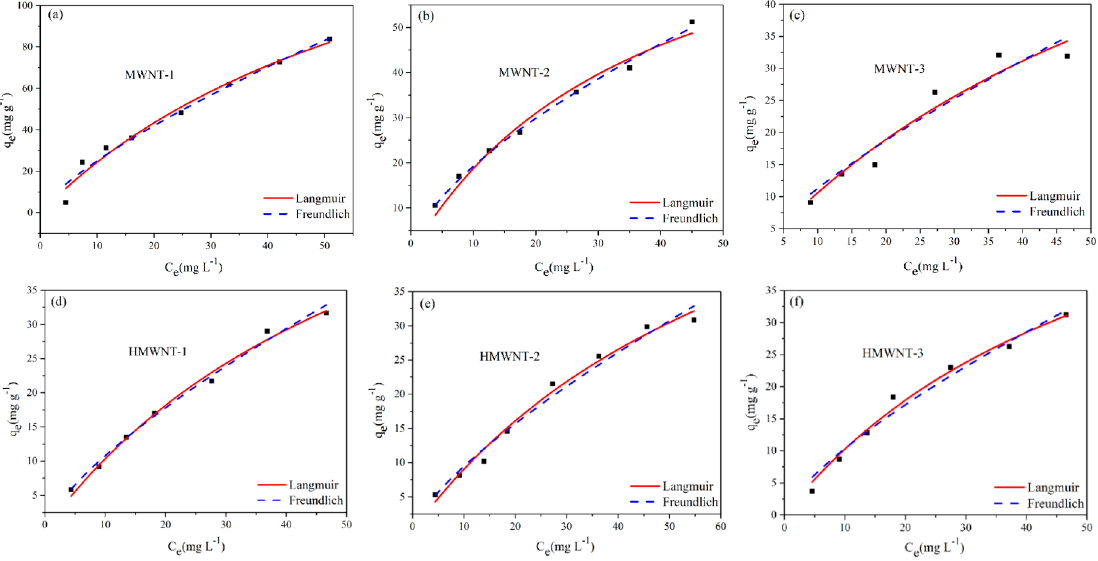
Figure 5. Langmuir and Freundlich adsorption isotherms for HA adsorption on MWNTs ( a – c ) and HMWNTs ( d – f ).